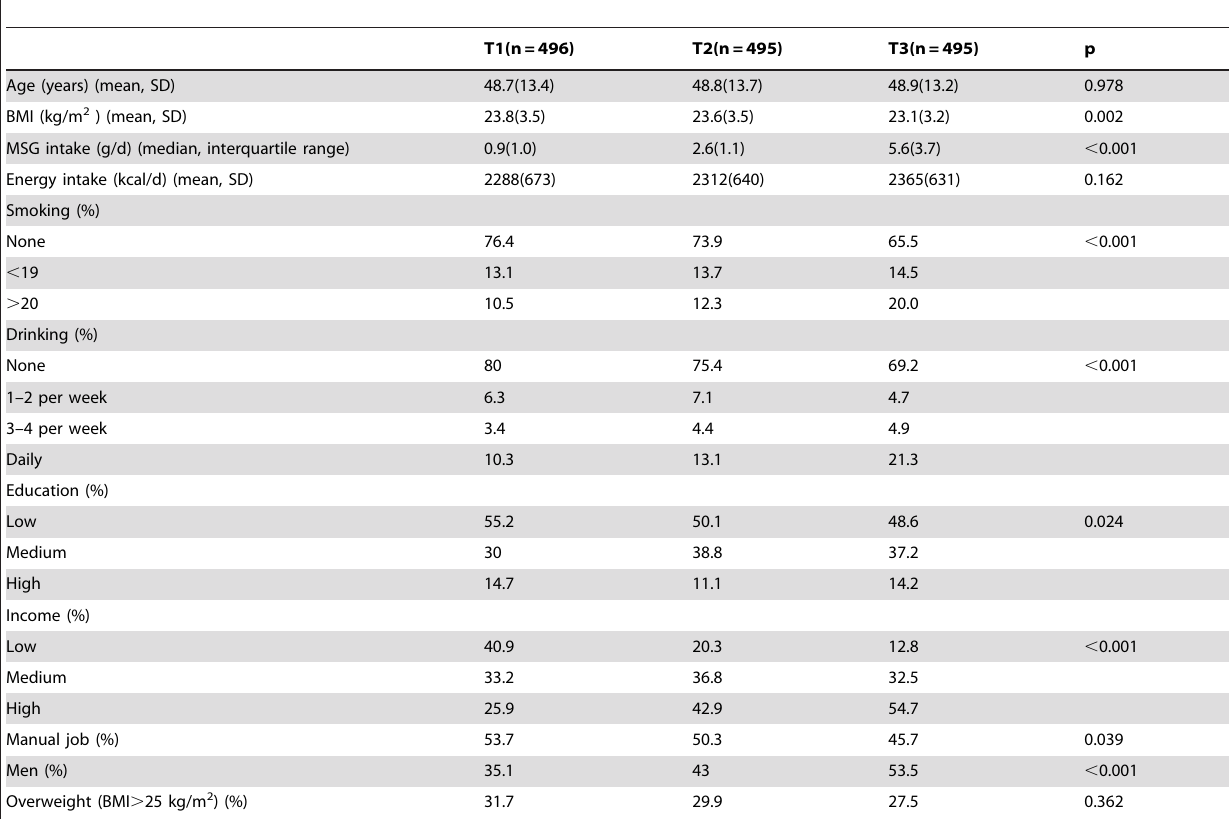
Table 1. Sample characteristic according to MSG intake tertiles among Chinese adults (Jiangsu Nutrition Study) (n=1486).